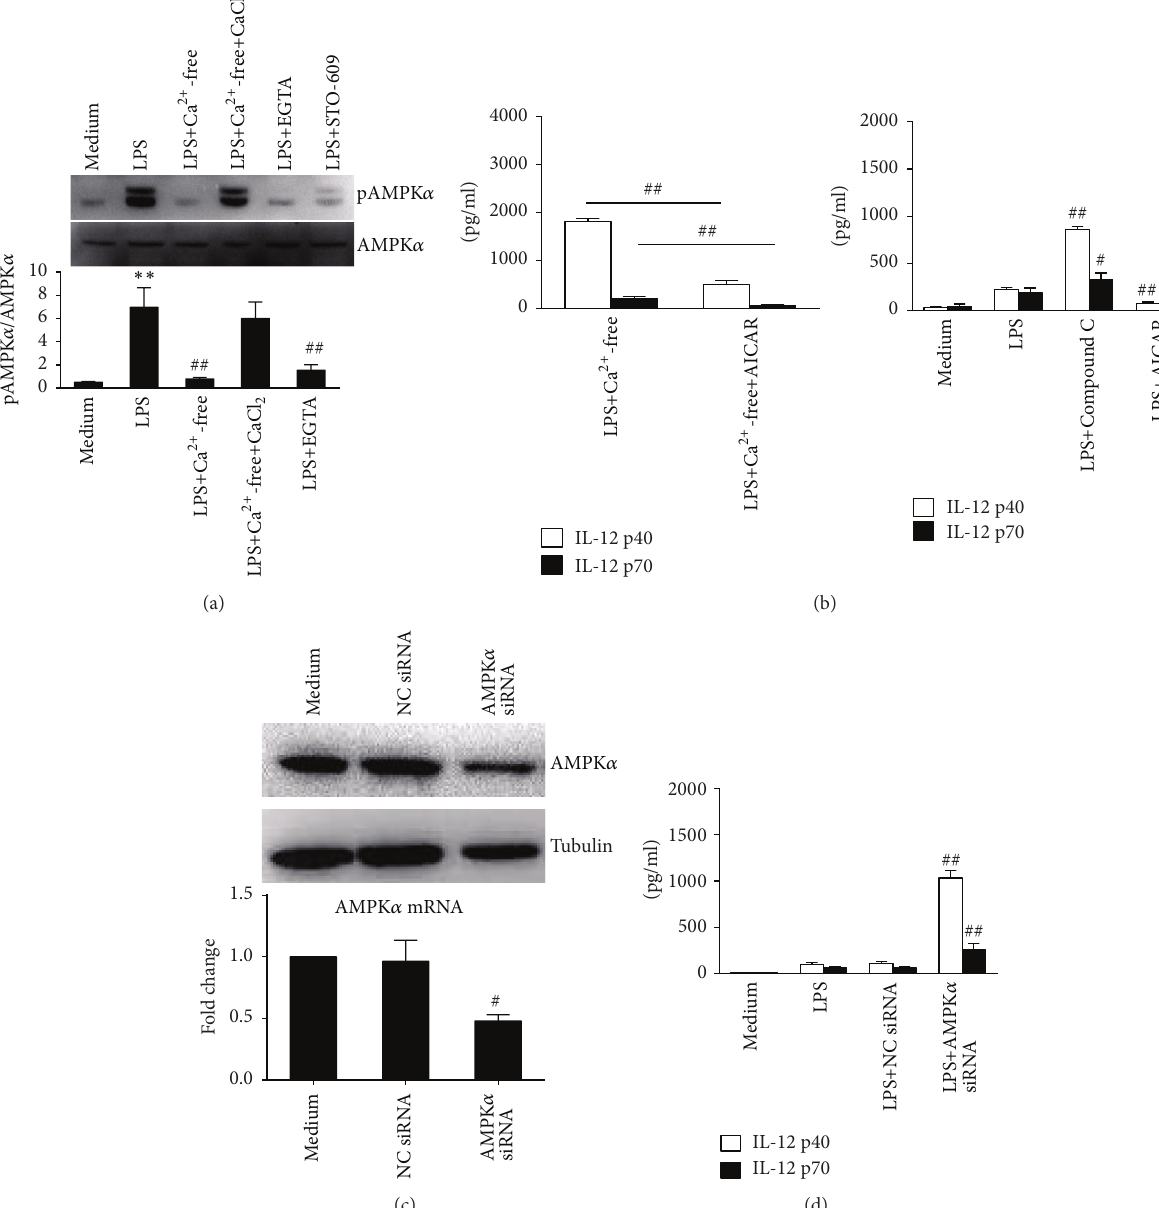
Figure 5: AMPK is activated downstream of CaMKK 𝛽 for the negative control of the LPS induced IL-12 production in RAW 264.7 cells. (a) Cells were treated with LPS alone or with calcium-free DMEM, 2 mM CaCl 2 , 5mM EGTA, or 1 𝜇 M STO-609 for 30min. Protein levels of AMPK 𝛼 and pAMPK 𝛼 were detected by western blot. ∗∗ 𝑃 < 0.01 versus medium; # 𝑃 < 0.05 or ## 𝑃 < 0.01 versus LPS ( 𝑛 = 3 ). (b) Cells were treated with LPS or LPS plus 1mM AICAR in calcium-free DMEM (left) or with LPS, LPS plus 5 𝜇 M Compound C, and LPS plus 1mM AICAR in normal DMEM (right). Supernatants IL-12 p40 and IL-12 p70 were detected by ELISA. # 𝑃 < 0.05 and ## 𝑃 < 0.01 versus LPS ( 𝑛 = 3 ). (c) Cells were treated with NC siRNA or AMPK 𝛼 siRNA for 24h. mRNA and protein levels of AMPK 𝛼 were detected by real-time PCR or western blot. # 𝑃 < 0.05 versus NC siRNA ( 𝑛 = 3 ) for mRNA. (d) siRNA-treated cells were further stimulated by 100ng/mL LPS for 24 h. Supernatants IL-12 p40 and IL-12 p70 (24h) were detected. # 𝑃 < 0.05 and ## 𝑃 < 0.01 versus LPS for each cytokine ( 𝑛 = 3 ).